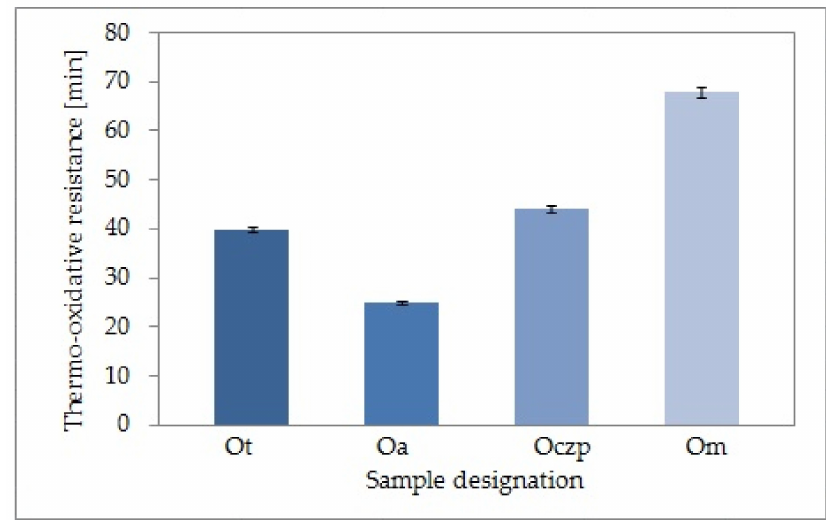
Figure 4. Thermo-oxidative resistance of the tested oils. Ot = strawberry seed oil, Oa = chokeberry seed oil, Oczp = black currant seed oil and Om = raspberry seed oil.